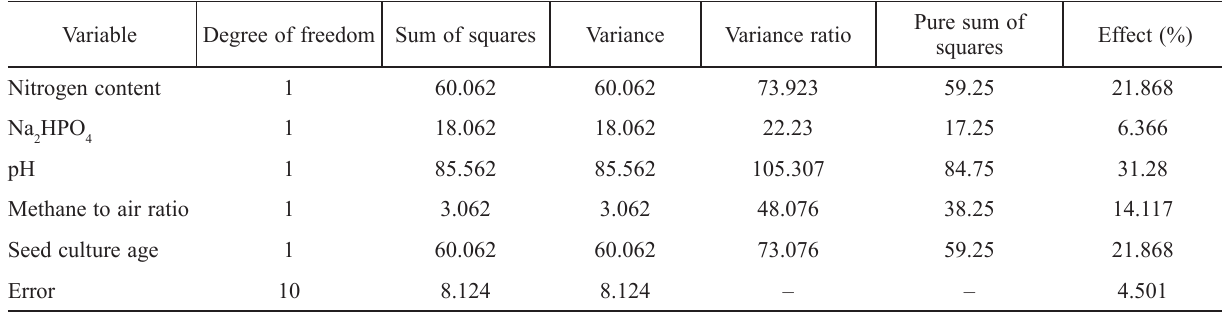
Table 4 – Analysis of variance of Taguchi method applied for PHB production in a bubble column bioreactor by the isolated methanot roph Variable Degree of freedom Sum of squares Variance